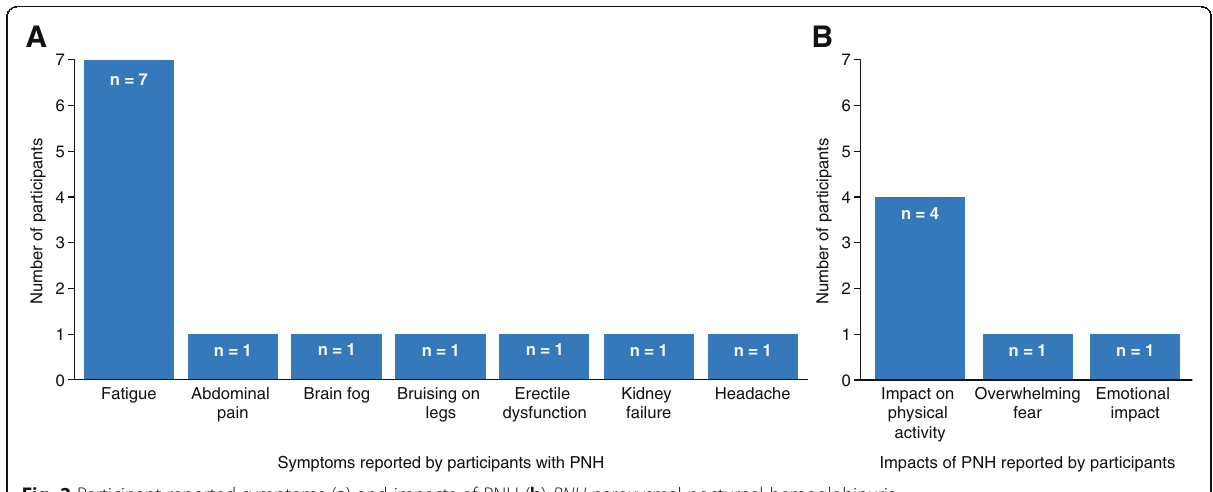
Fig. 2 Participant-reported symptoms ( a ) and impacts of PNH ( b ) PNH paroxysmal nocturnal